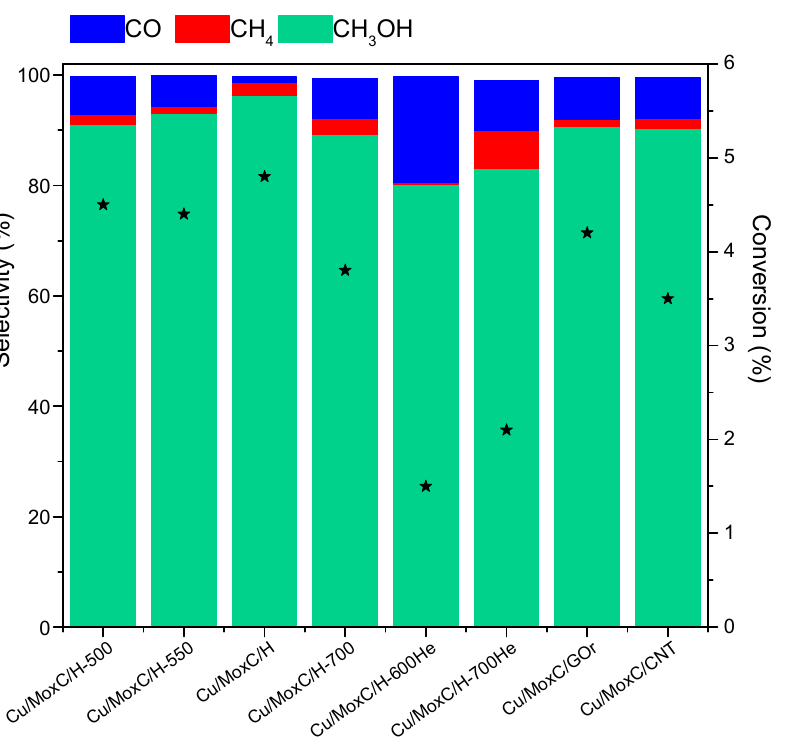
Figure 4. Conversion of CO 2 (scatter in the right axes) and selectivity (in bars left axes) to CH 3 OH, CH 4 , and CO at 150 °C and 20 bar.